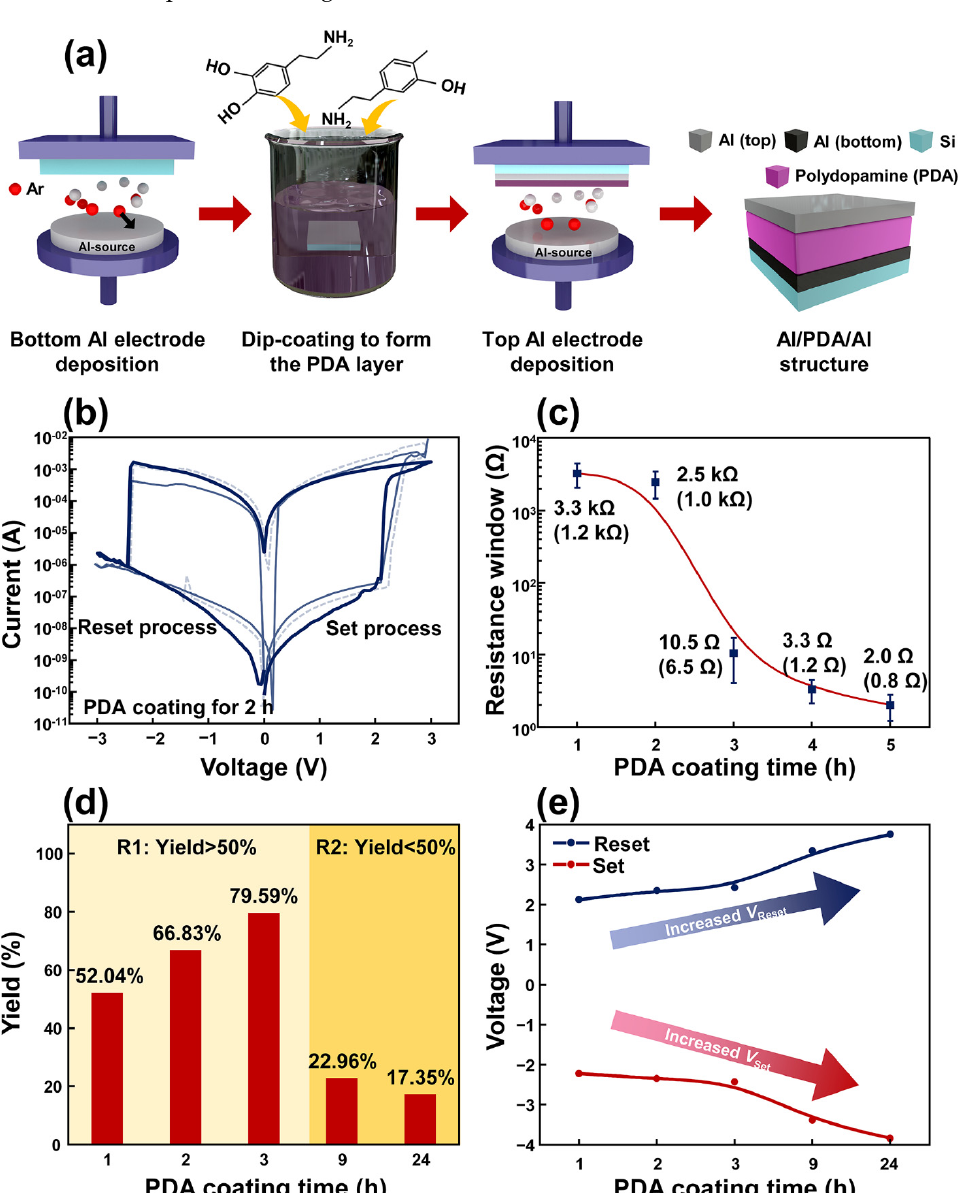
Figure 1. ( a ) Schematic diagram describing the fabrication process of an Al/PDA/Al structure. ( b ) Typical I–V characteristics of the Al/PDA/Al structure coated with a PDA layer for 2 h indicating a bipolar property. ( c ) The resistance window of the Al/PDA/Al structure according to the PDA coat- ing time and standard deviation values in parentheses. ( d ) The yield of the Al/PDA/Al structure showing resistive-switching characteristics according to the PDA’s coating time. ( e ) Trends of the V Set and V Reset at various PDA coating times. To use Al/PDA/Al structures as resistive random-access memory devices, the on/off ratio (resistance window) should be also considered. When the coating time of the PDA